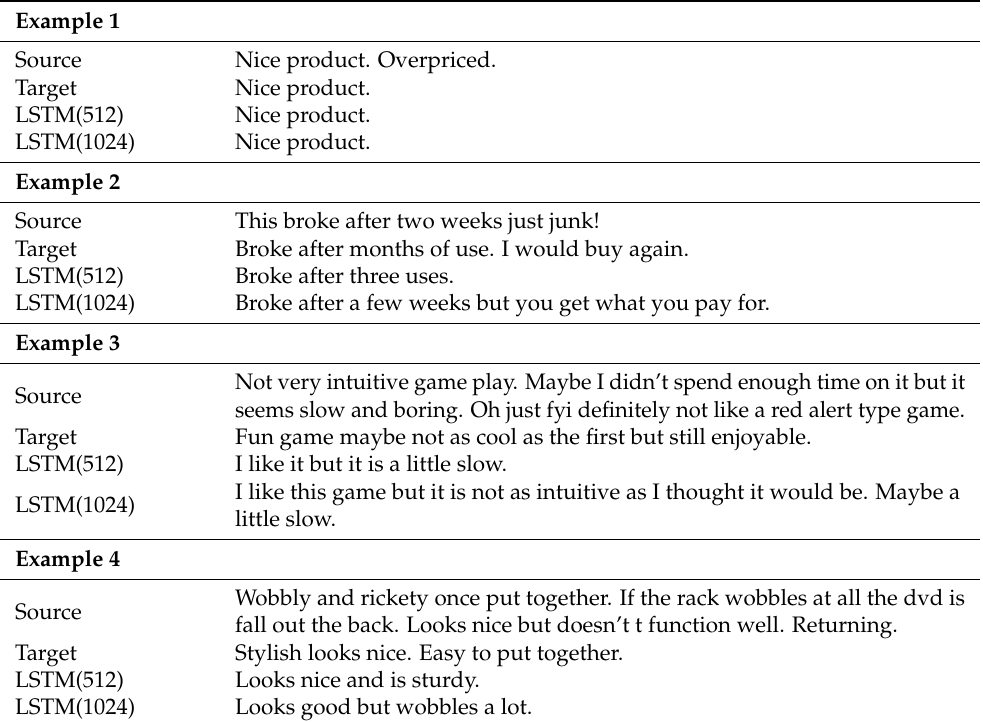
Table 5. Expected translated sentimental